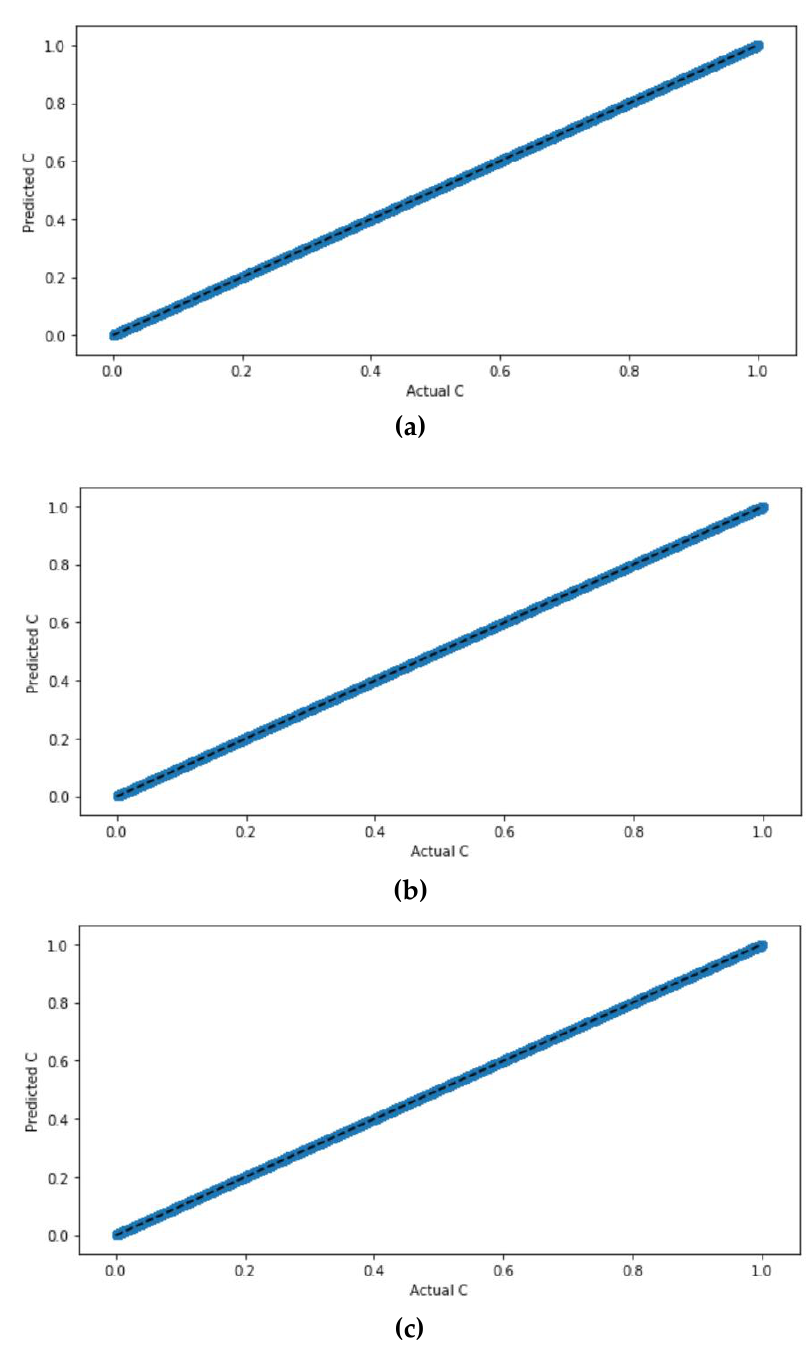
Figure 3. Scatter plots of ANN models with different activation functions (a) “ReLu” activation function, (b) “sigmoid” activation function, and (c) “tan h ” activation function , for target C . The dashed line represents a full coinciding between actual and predicted data.